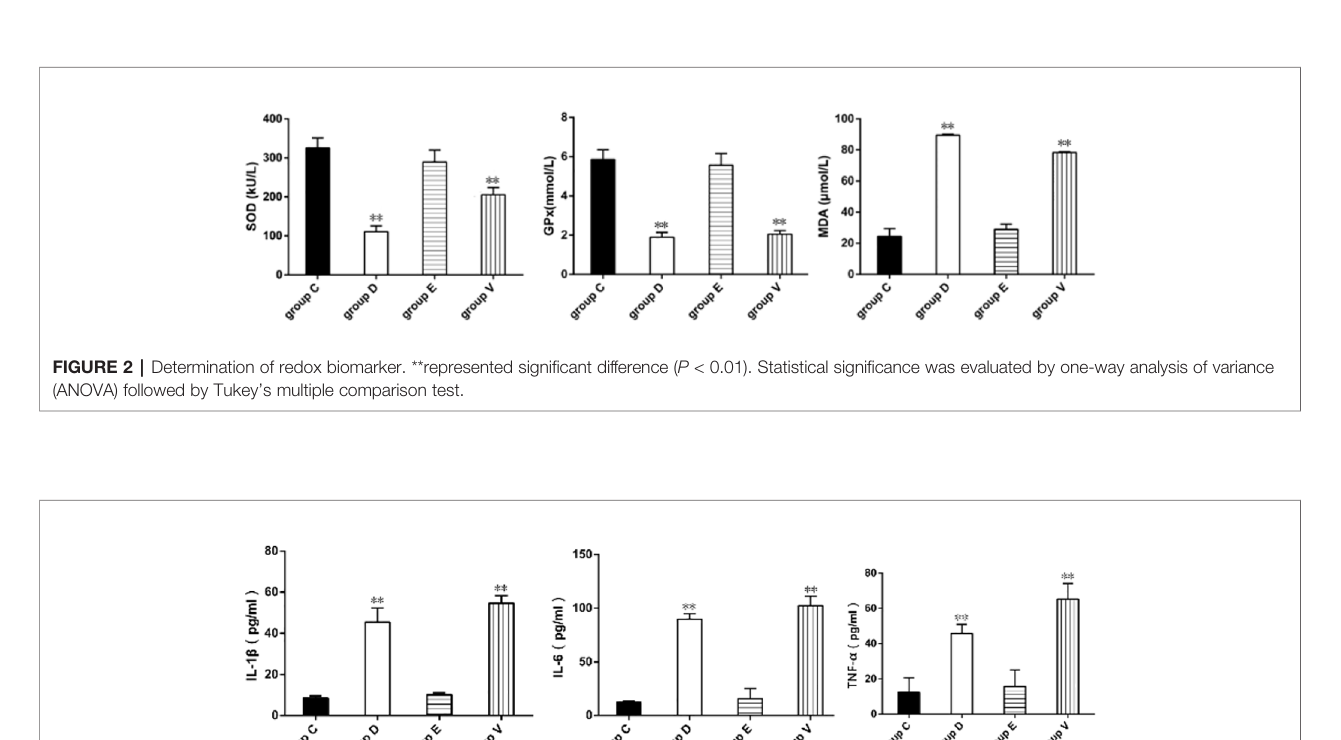
FIGURE 1 | Ileums slices using HE staining. (A – D) were in the 400 × magni fi cation.